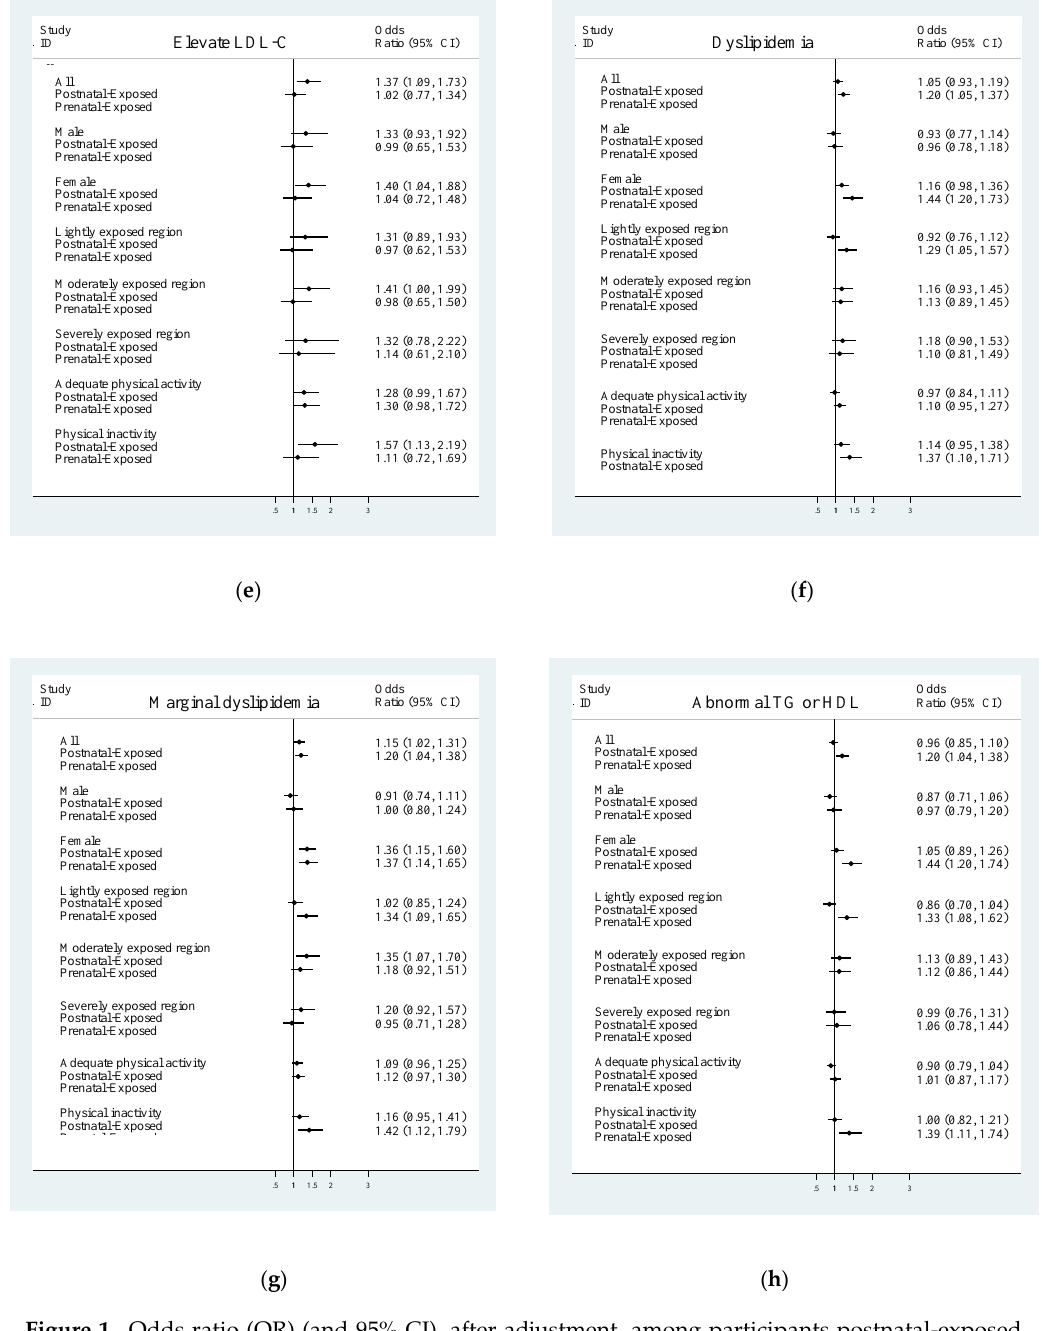
Figure 1. Odds ratio (OR) (and 95% CI), after adjustment, among participants postnatal-exposed, prenatal-exposed and unexposed participants. ( a ) with elevated TG; ( b ) in marginally elevated TG; ( c ) with elevated TC; ( d ) with low HDL-C; ( e ) with elevated LDL-C; ( f ) with dyslipidemia; ( g ) with marginal dyslipidemia; ( h ) with abnormal TG or HDL.